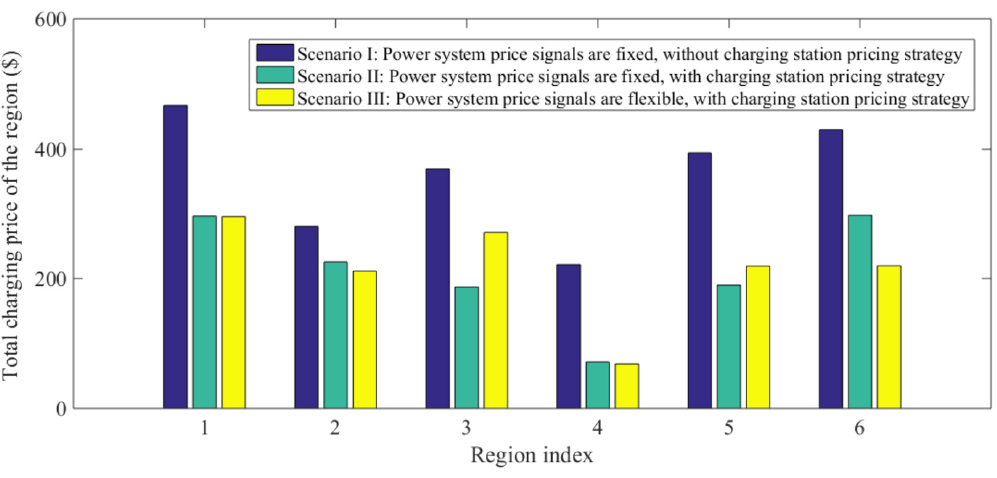
Figure 14. Total charging demand of each region under various scenarios.